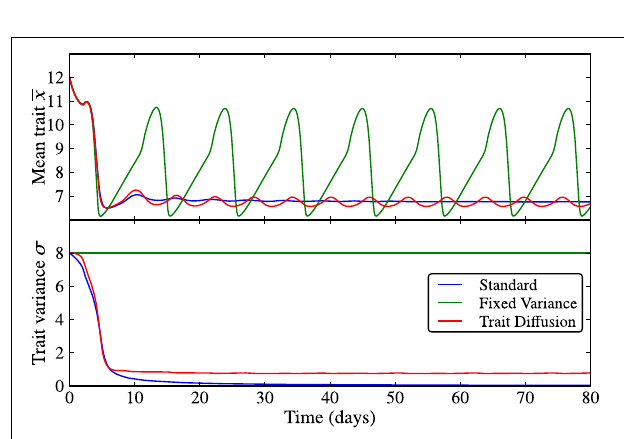
FIGURE 2 | Limit cycle dynamics from a state of high initial diversity ( σ (0) = 8). Analogously to the case of low initial diversity ( Figure 1 ), the trait variance converges to zero in the standard model (blue line), it is constant by construction in the model with fixed variance (green line), and it shows an initial relaxation to a steady-state with almost imperceptible superimposed oscillations in the trait diffusion model (red line). The model with fixed variance shows high-amplitude oscillations in the mean trait. The standard model clearly loses adaptive capacity in the long term (i.e., oscillations in the mean trait become weaker as the trait variance approaches zero). The corresponding NPZ dynamics is shown in Supplementary Figure 2.